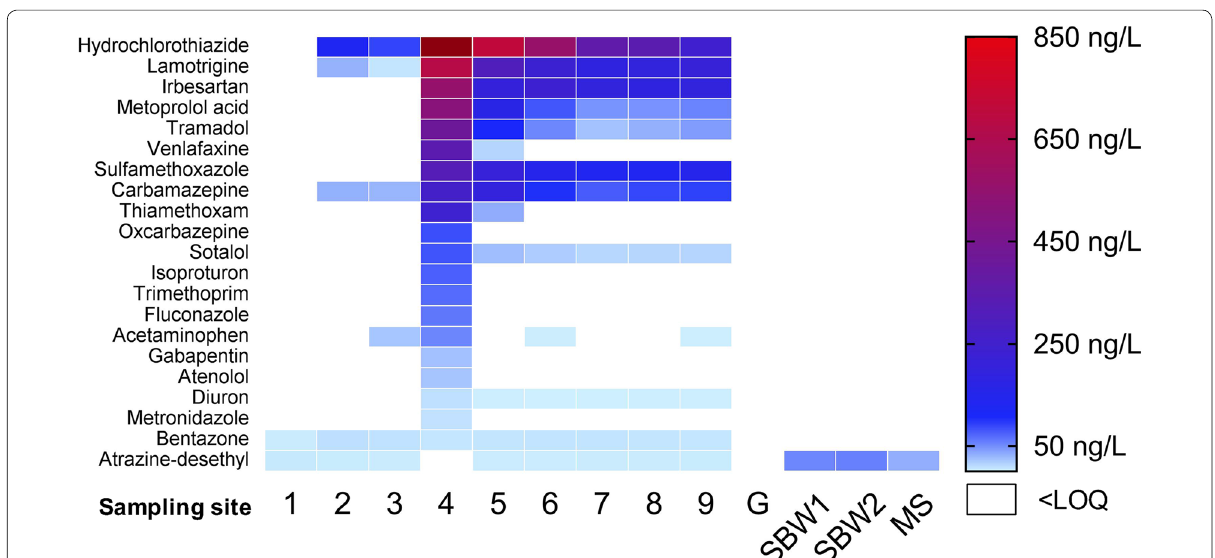
Fig. 2 Detected target pollutants from sampling sites 1 to 9 along the Ammer River, the tributaries Schönbrunnen (SB) and Mühlbach (MS) and from one sample of the Kleiner Goldersbach (G) creek. The concentration of hydrochlorothiazide at site 4 was 1.9 µg L − 1 which exceeds the concentration scale and is colored in dark